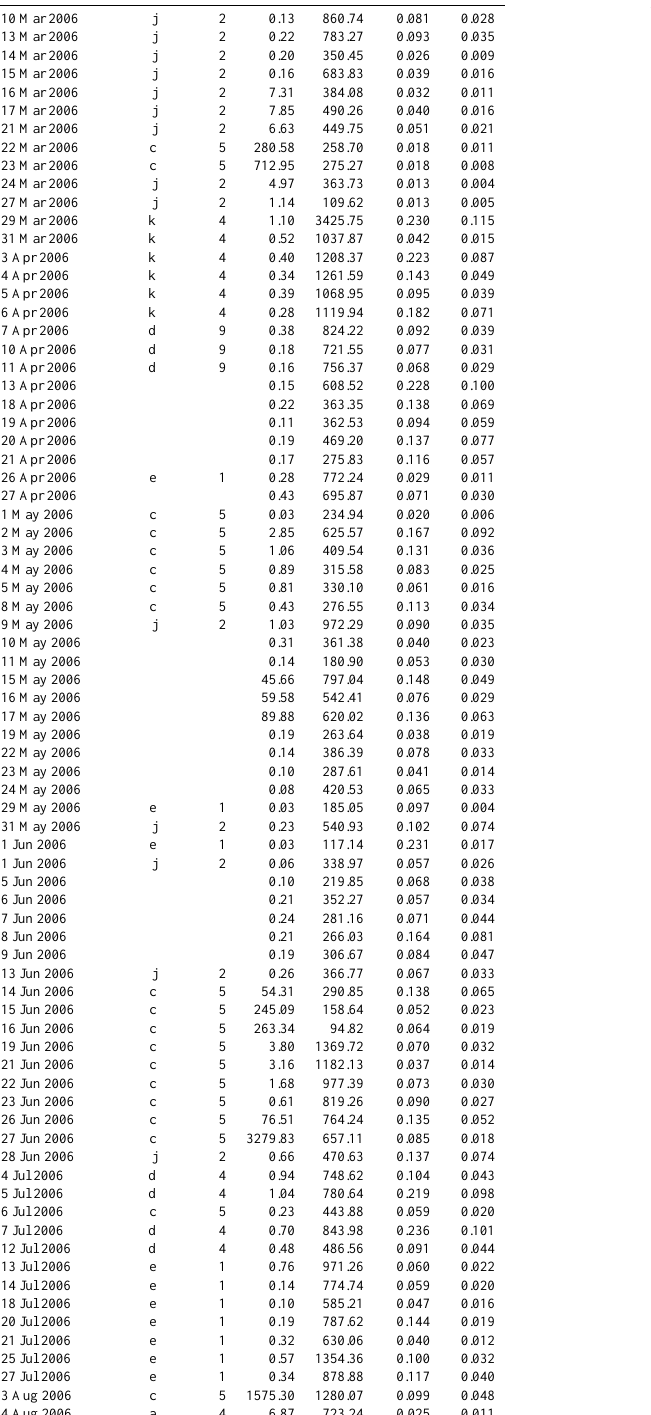
Table 4b. Mean daily backgrounds in µgg − 1 equivalent from tun- ing using the Tune-1